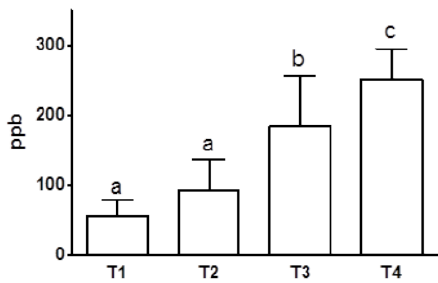
Figure 2. Blood fluoxetine concentrations after one (T1), two (T2), four (T3), and six (T4) months of fluoxetine treatment (1.5 mg/kg/day PO) (T1/T2 vs. T3/T4 p < 0.001; T3 vs. T4 p < 0.01; n = 8). a, b, c: statistically significant differences are present among the values reported in the bar of the graph.